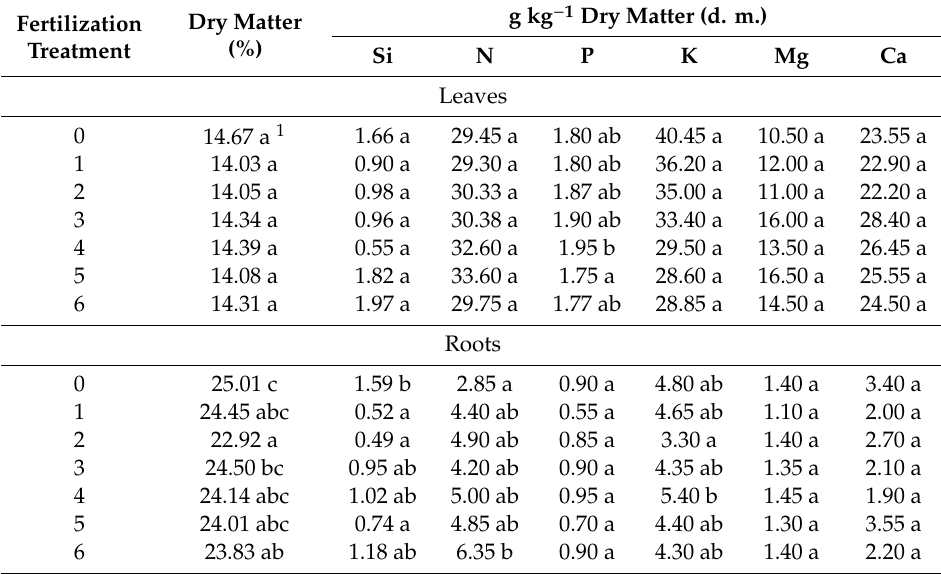
Table 1. The e ff ect of foliar fertilization with macro- and micronutrients on the chemical content of sugar beet leaves and roots (mean values from 2013 to